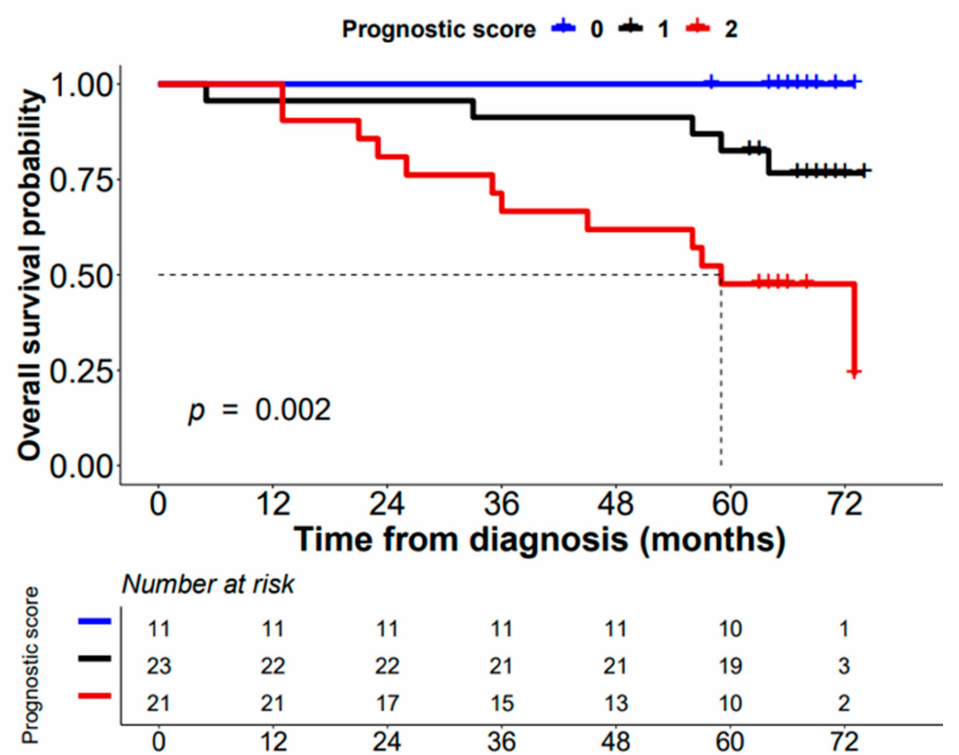
Figure 6. Overall survival (OS) of sCRC patients stratified by the prognostic score proposed in the present study. This prognostic score was based on the altered expression of the most relevant genes predicting OS in the multivariate analysis ( ADH1B (NM_001286650), BST2 , and FER1L4 ). Score 0: transcripts for ADH1B (NM_001286650), BST2 , and FER1L4 expressed at low levels. Score 1: one of these genes is expressed at a high level. Score 2: two or three of these genes are expressed at a high